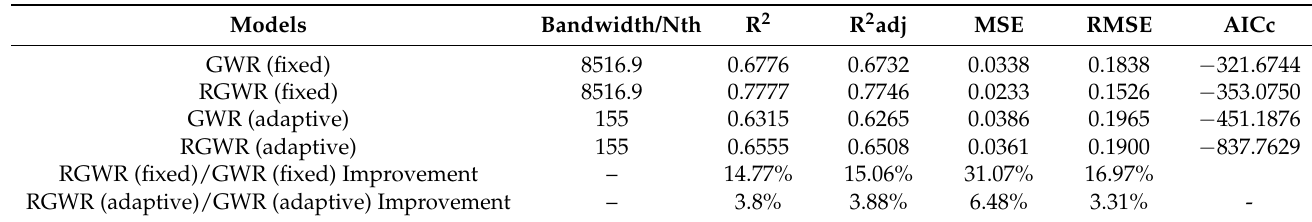
Table 4. The value of the RGWR and GWR